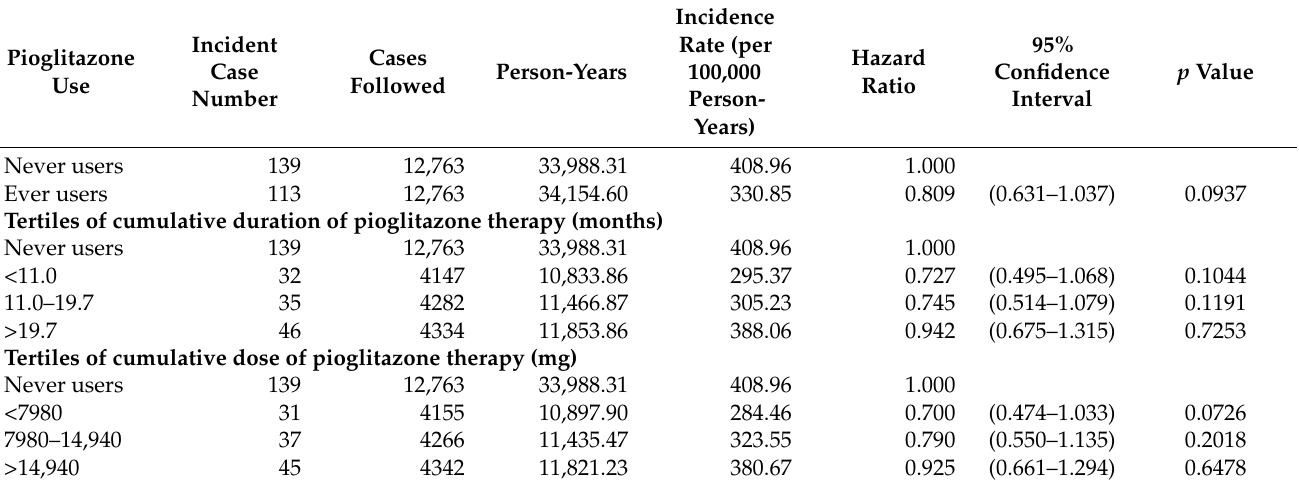
Table 2. Incidence rates of inflammatory bowel disease and hazard ratios comparing pioglitazone exposed groups to the unexposed group.